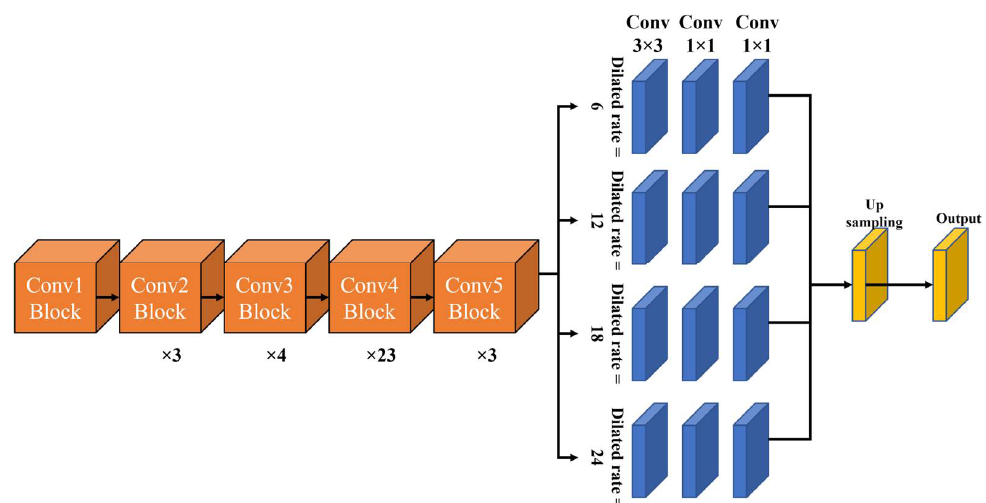
Figure 6. Structure of DeepLabv2 model.